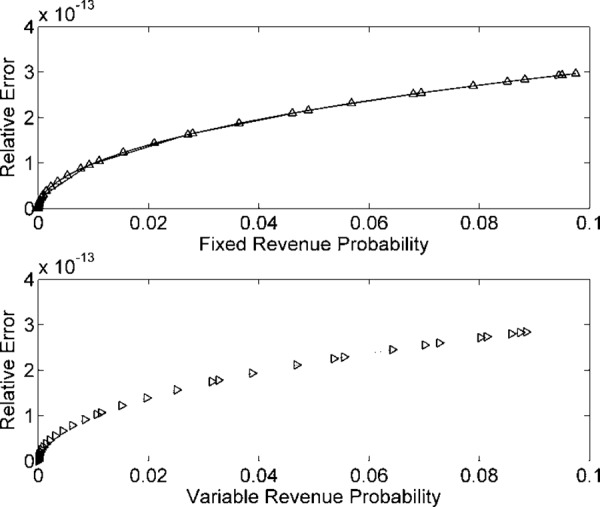
REs in RF(t) and Rv(t) for n = 108 samples.